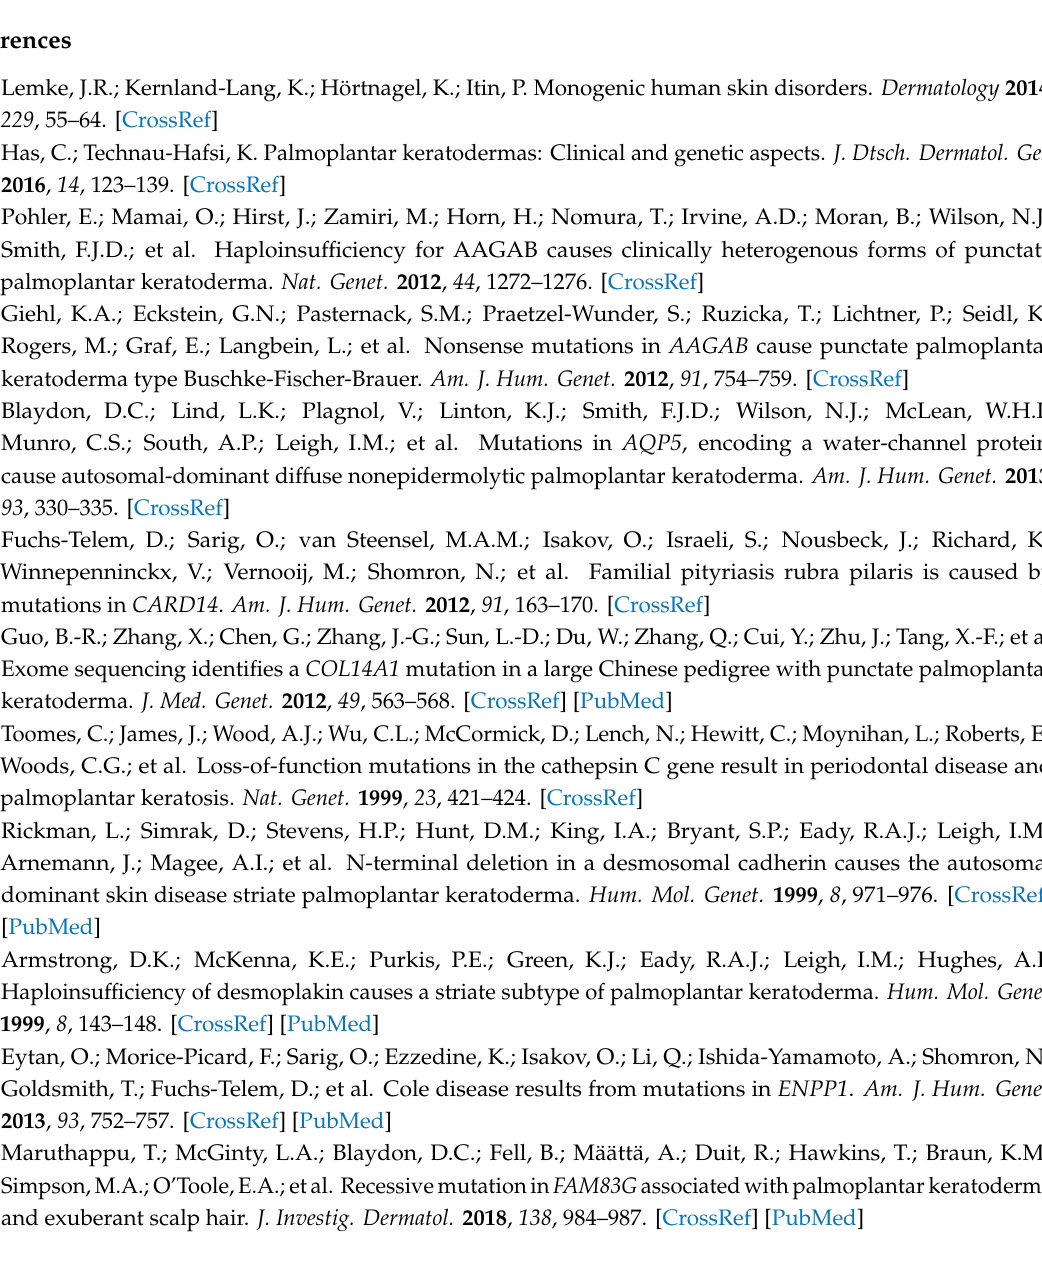
Figure S1: Hyperkeratotic plaque at the elbow of the a ff ected dog. Table S1: Accession numbers of 648 dog and 8 wolf genome sequences; Table S2: Private variants in the sequenced Rottweiler with footpad